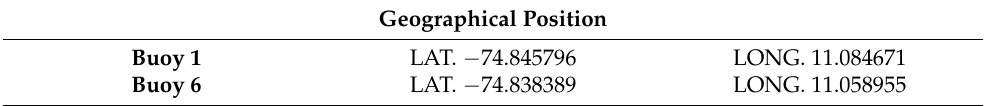
Table 2. Buoy location coordinates.